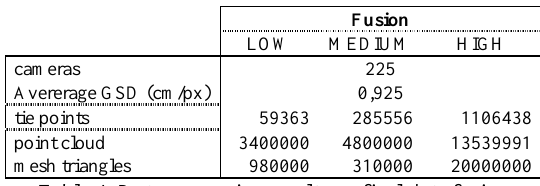
Table 4. Data processing results on final data fusion